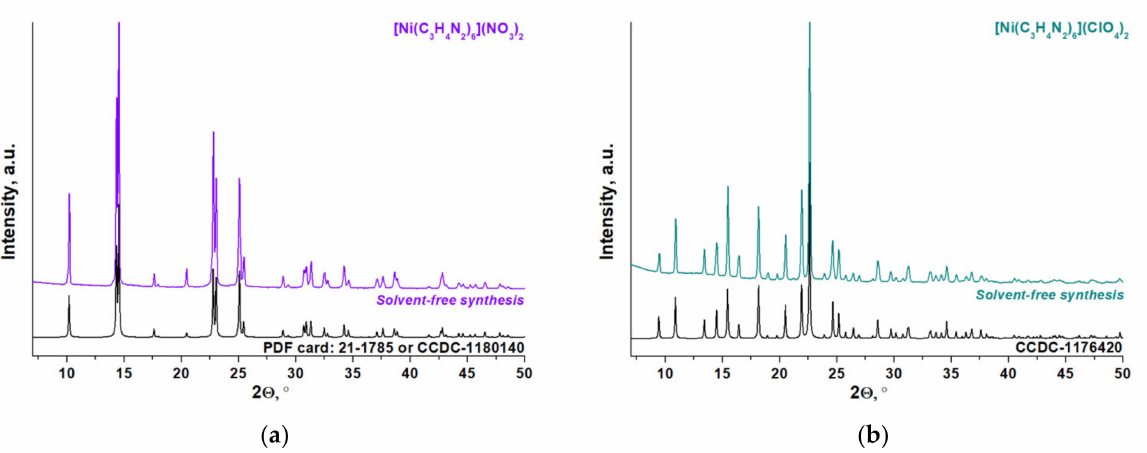
Figure 3. Powder XRD data for synthesized ( a ) [Ni(C 3 H 4 N 2 ) 6 ](NO 3 ) 2 [40] and ( b ) [Ni(C 3 H 4 N 2 ) 6 ] (ClO 4 ) 2 [41]